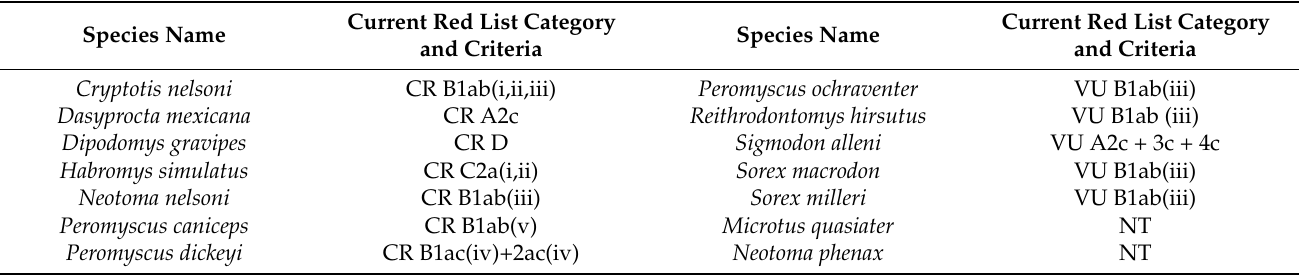
Table A2. Species Red List accounts to be reviewed because of new information gathered during the